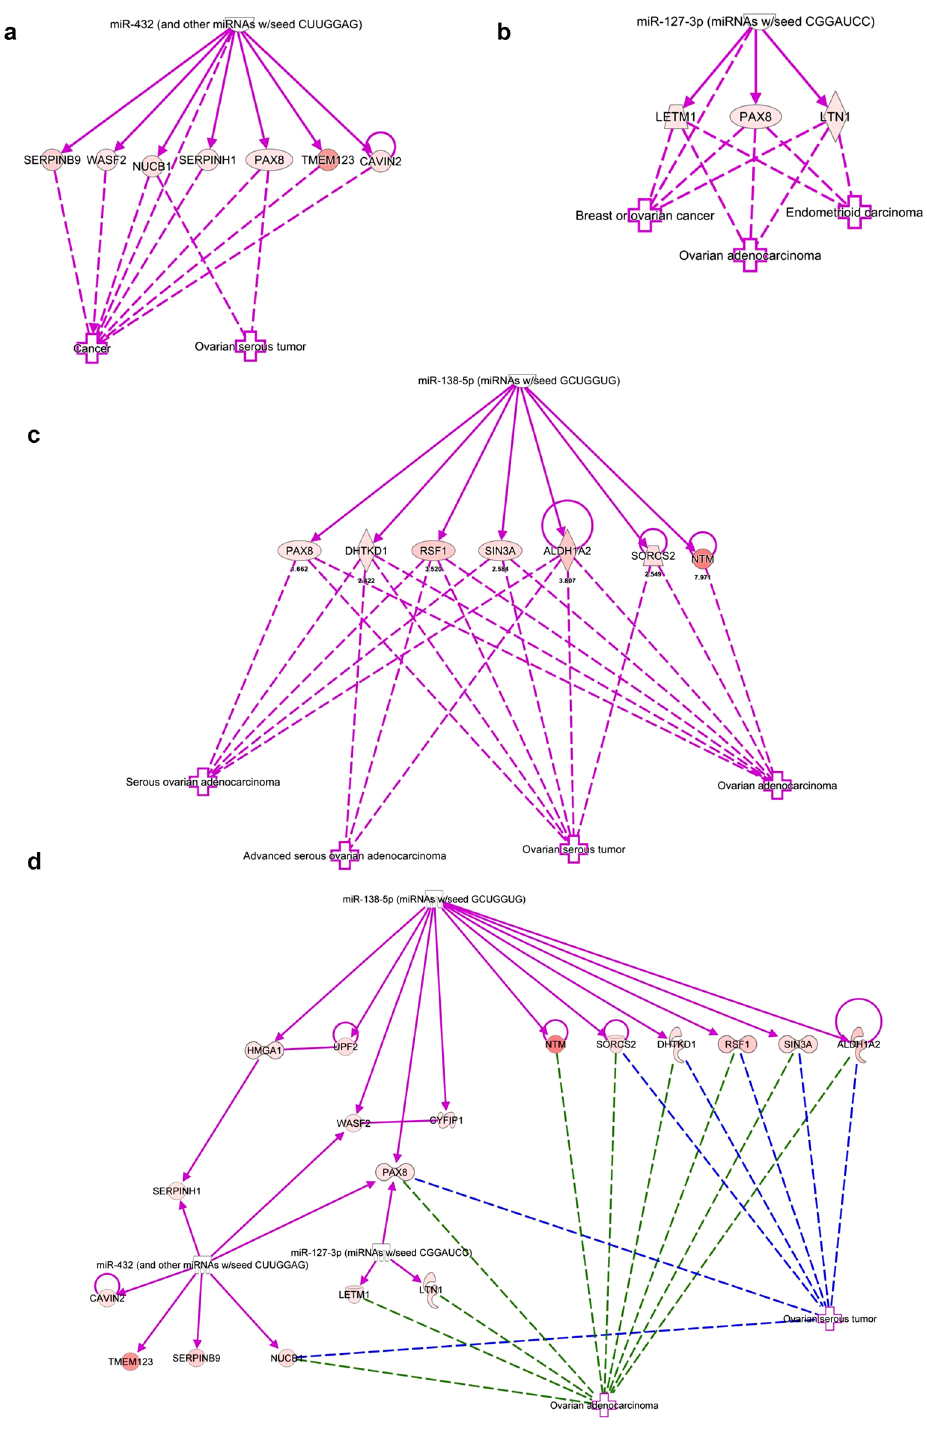
Figure 5. Protein targets of miR-138-5p, miR-432-5p, and miR-127-3p associated with gynecological cancers, predicted via IPA analysis. In co-relation with ovarian serous tumors, ( a ) 7 targets identified for miR-432 analysis and in correlation with gynecological malignancies, ( b ) 3 targets identified for miR-127-3p and ( c ) 7 targets for miR-138-5p analysis. ( d ) Combined target network analysis of miR-432, miR-127-3p and miR-138-5p in relation to their association with ovarian carcinoma revealed PAX8 as a common target of all three